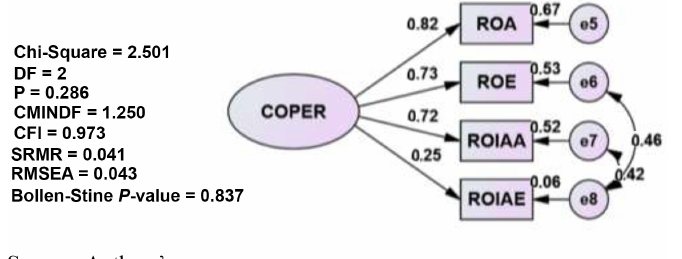
Figure 3. SFC model